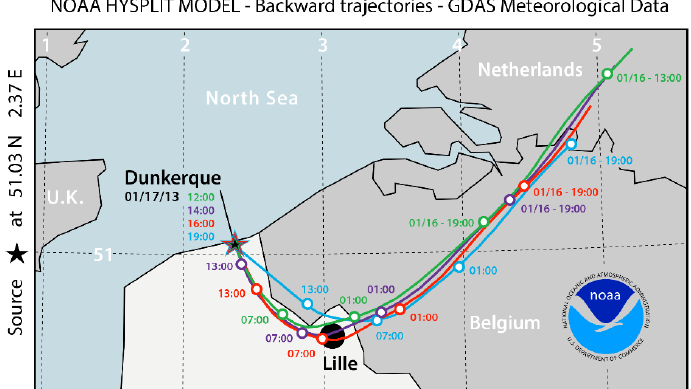
Figure 10. Air mass back trajectories (NOAA HYSPLIT) for the observed episode during the period of